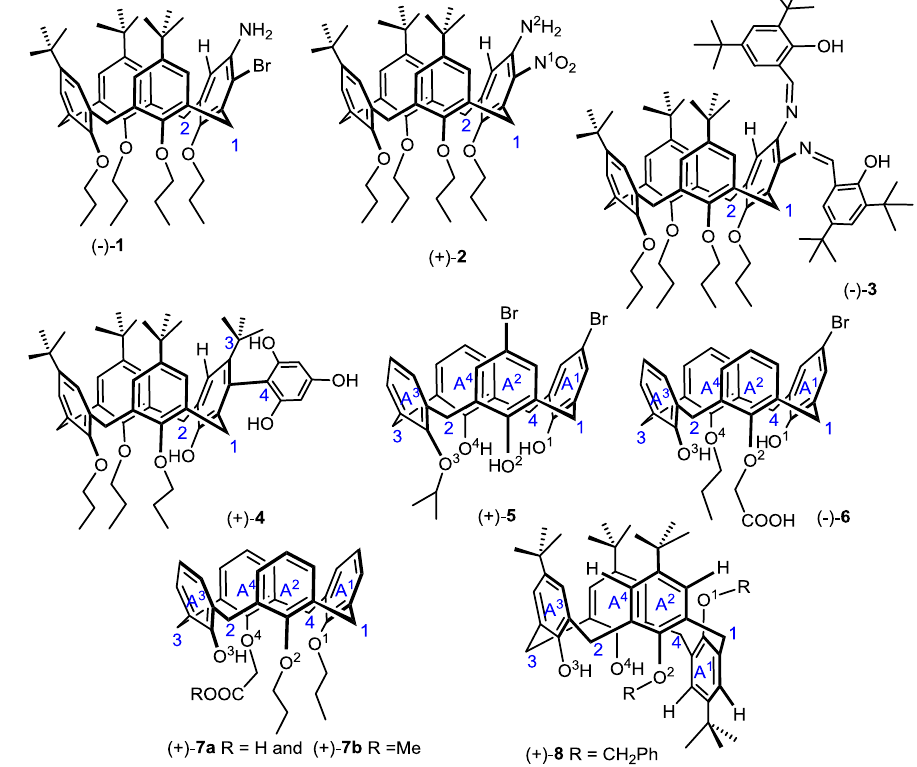
Figure 3. Inherently chiral calix[4]arenes, whose absolute configuration and optical rotation sign have been